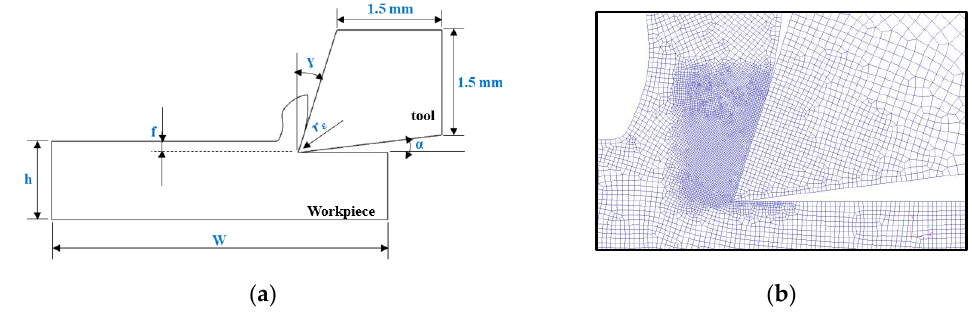
Figure 2. ( a ) Workpiece and tool geometry and ( b ) Mesh generation. Table 2. Mechanical and thermal properties of the workpiece and tool ( reprinted with permission Table 2. Mechanical and thermal properties of the workpiece and tool (reprinted with permission from [5] , 2023, Licence No 5513161238525, Springer nature). from [5], 2023, Licence No 5513161238525, Springer nature).